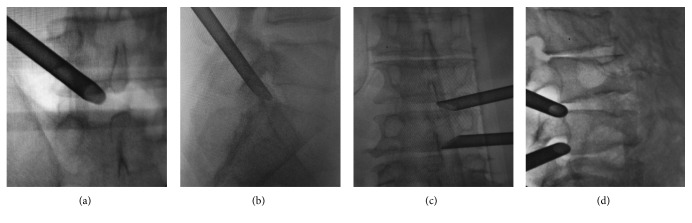
Surgical procedures of two-level PELD and foraminoplasty PELD. (a, b) Working channels placed into the intervertebral foramen at the L5/S1 level. (c, d) Two-level working channels placed into the intervertebral foramen at the L3/4 and L4/5 level.